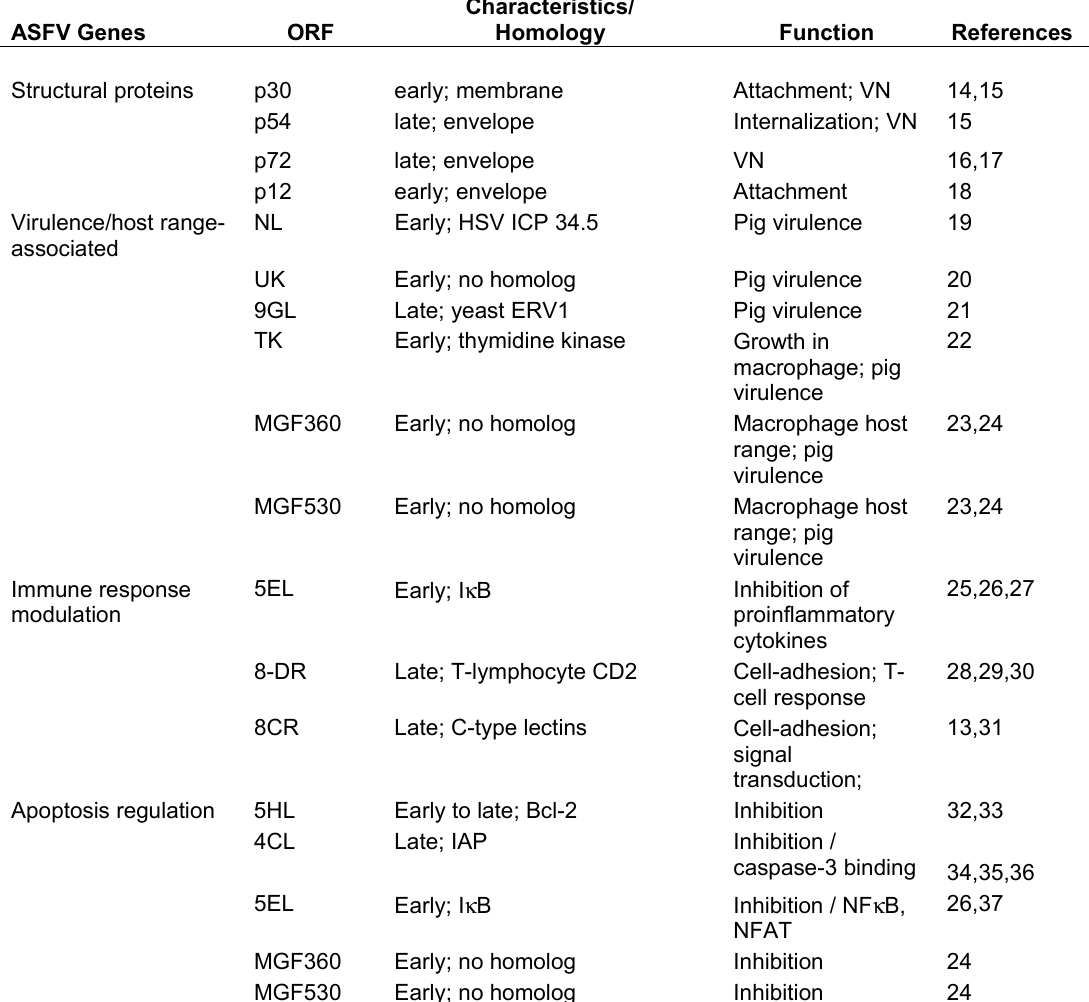
African Swine Fever Virus Genes with Predicted and/or Identified Functions in Critical Virus-Cell Interactions